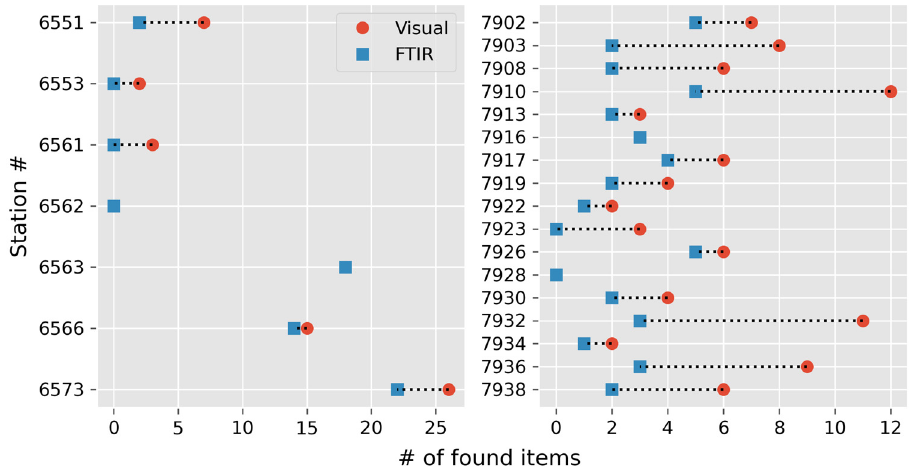
Figure 2. Number of items found by visual identification and identification using FT-IR for surface ( left ) and subsurface ( right ).